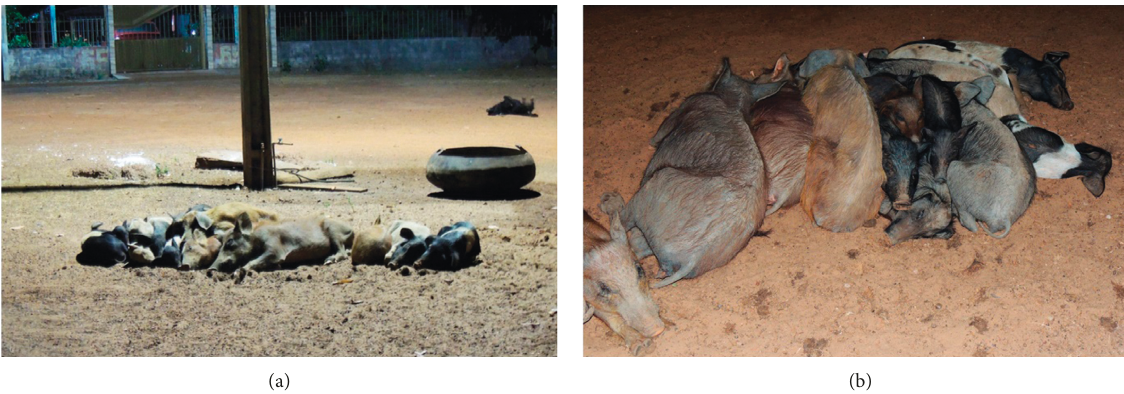
Figure 1: Pigs circulating freely on the streets in the municipality of Nossa Senhora de Nazar´e, Piau´ı, Brazil.